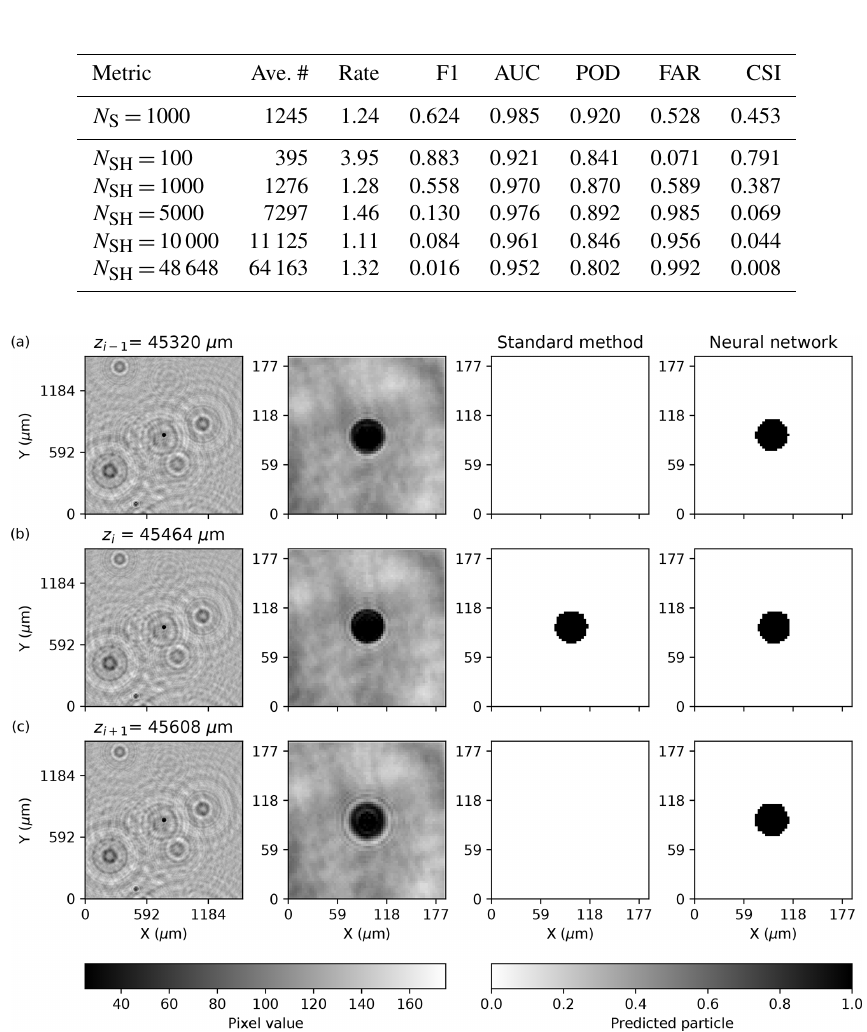
Figure 5. Three successive planes are shown in (a) – (c) . Each row illustrates the tile image at z , the center of the tile image zoomed in, the prediction by the standard method, and the mask prediction by the N SH = 1000 neural network model. The pixel values ranged from 0 to 255 in the holograms images. The standard method prediction is the result of a clustering procedure that eliminated the particle in multiple